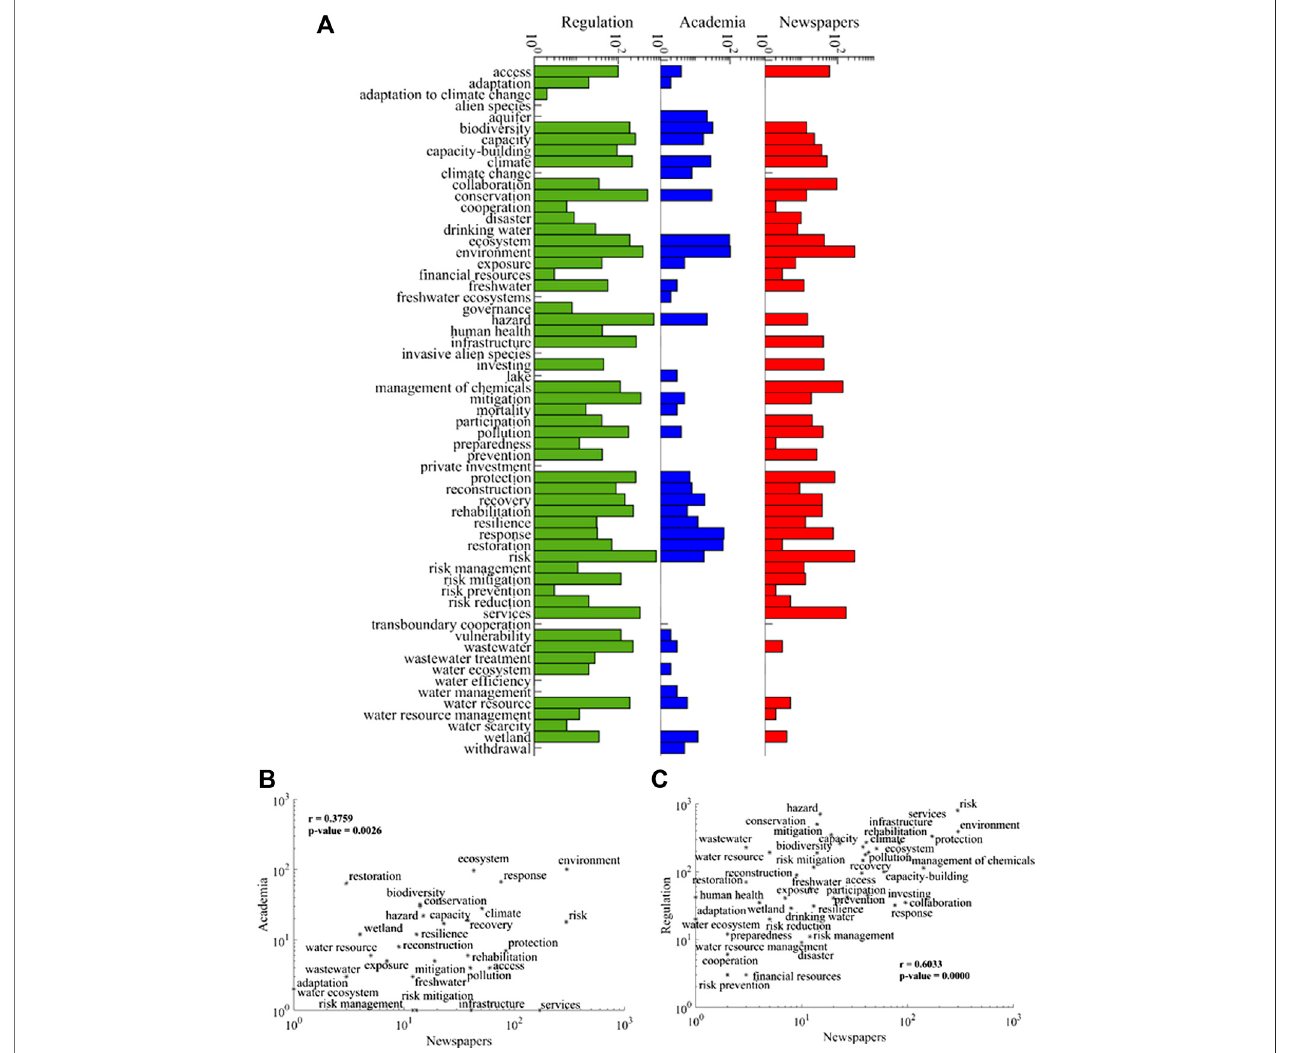
FIGURE 3 | (A) Absolute number of occurrences ( x axis) of UN keywords ( y axis, organized in alphabetical order) in regulatory (green), academic (blue) and newspaper (red) documents. Only the keywords with at least one occurrence in both sources in a given panel are listed. (B – C) Scatterplots of absolute number of occurrences ofUNkeywordsin (B) academic and (C) regulatorysources, vs. theabsoluteoccurrencenumberinnewspapers(each datapointrepresentsaword). Data shown in log-log space.